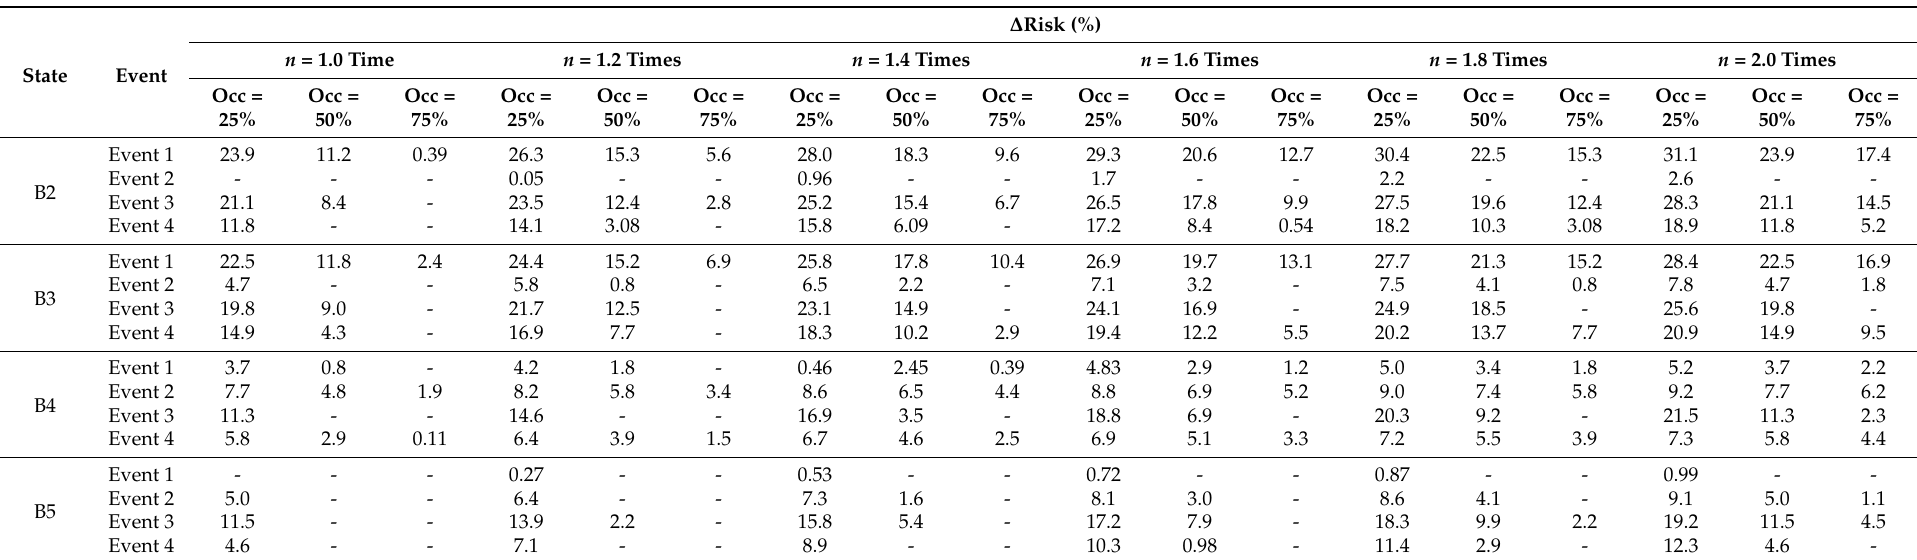
Table 7. The comprehensive effect of the measures on the risk